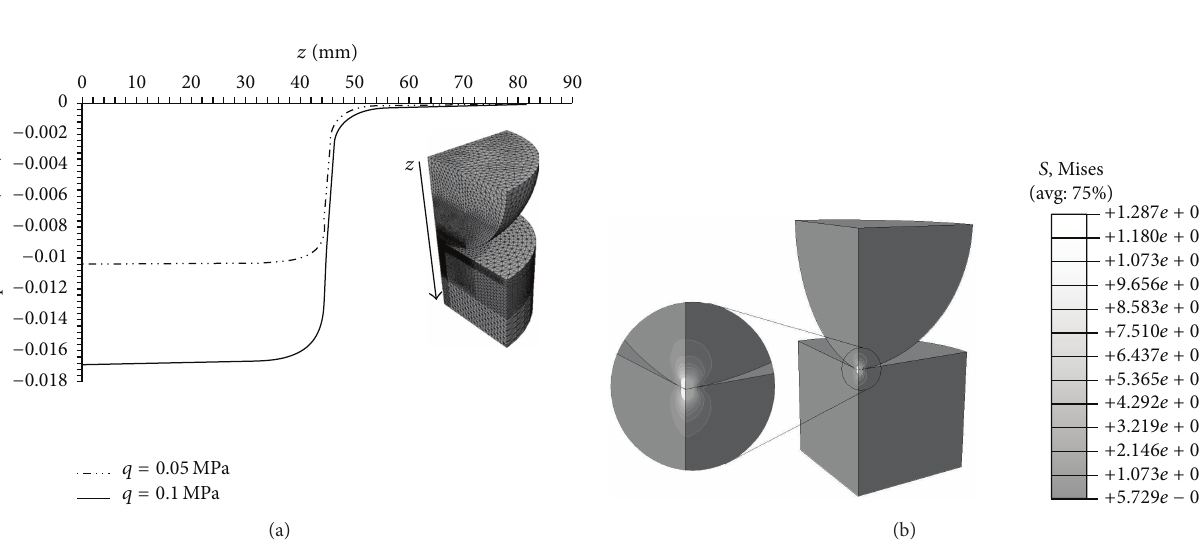
Figure 20: Vertical displacements versus position at different loads levels (a); Von Mises stress